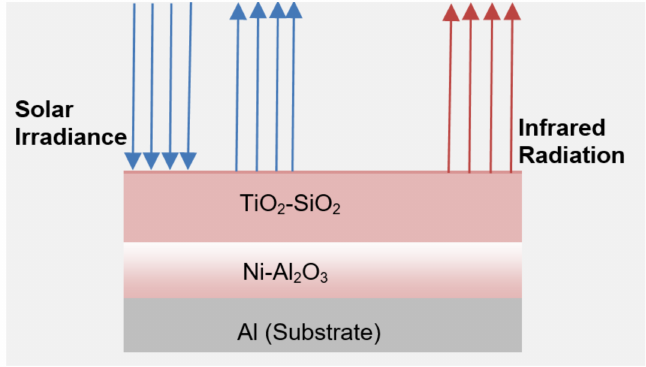
Figure 1. Schematics showing of the proposed radiative